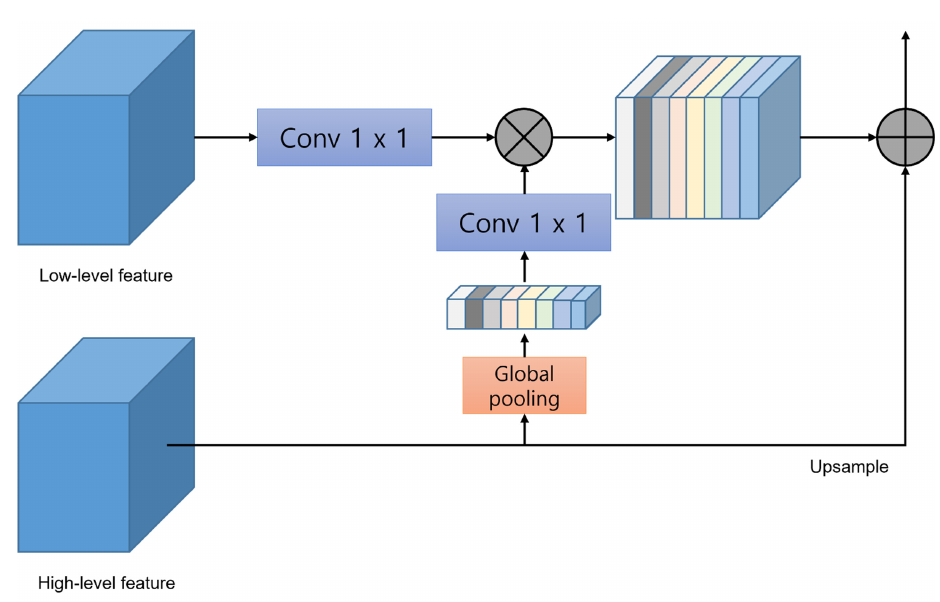
Figure 5. Structure of GAU in which high-level and low-level features are added together and upsampled to create features.